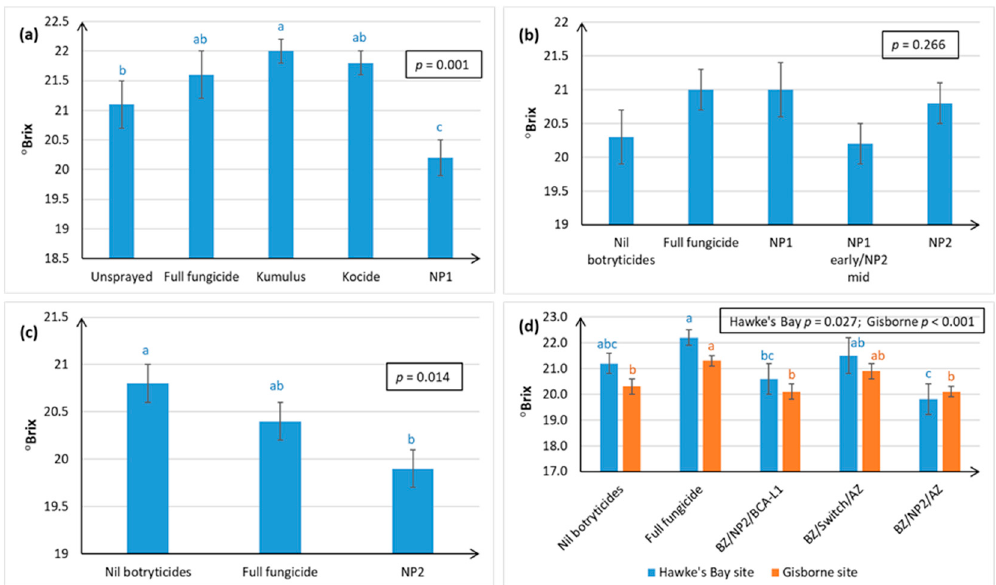
Figure 7. Fruit maturity (as indicated by °Brix) in Chardonnay berries, as assessed at harvest in April, over four successive seasons. Treatments are described in full in Tables S1 and S2, and briefly in Figures 1 and 2. Each graph represents data from a separate season, with error bars indicating standard errors, boxed values showing probabilities obtained from ANOVA, and different letters indicating statistically significant differences from Fisher’s Least Significant Difference ((LSD, p ≤ 0.05), which are only presented when the ANOVA p ≤ 0.05. The concentration of the active ingredient in the NP formulation is indicated in parentheses for each specific experiment. ( a ) Season 1, Hawke’s Bay site, NP1 (7 g/L); ( b ) Season 2, Hawke’s Bay site, NP1 (7 g/L) and NP (15 g/L); ( c ) Season 3, Hawke’s Bay site, NP2 (5 g/L); ( d ) Season 4, Hawke’s Bay and Gisborne sites, NP2 (5 g/L).